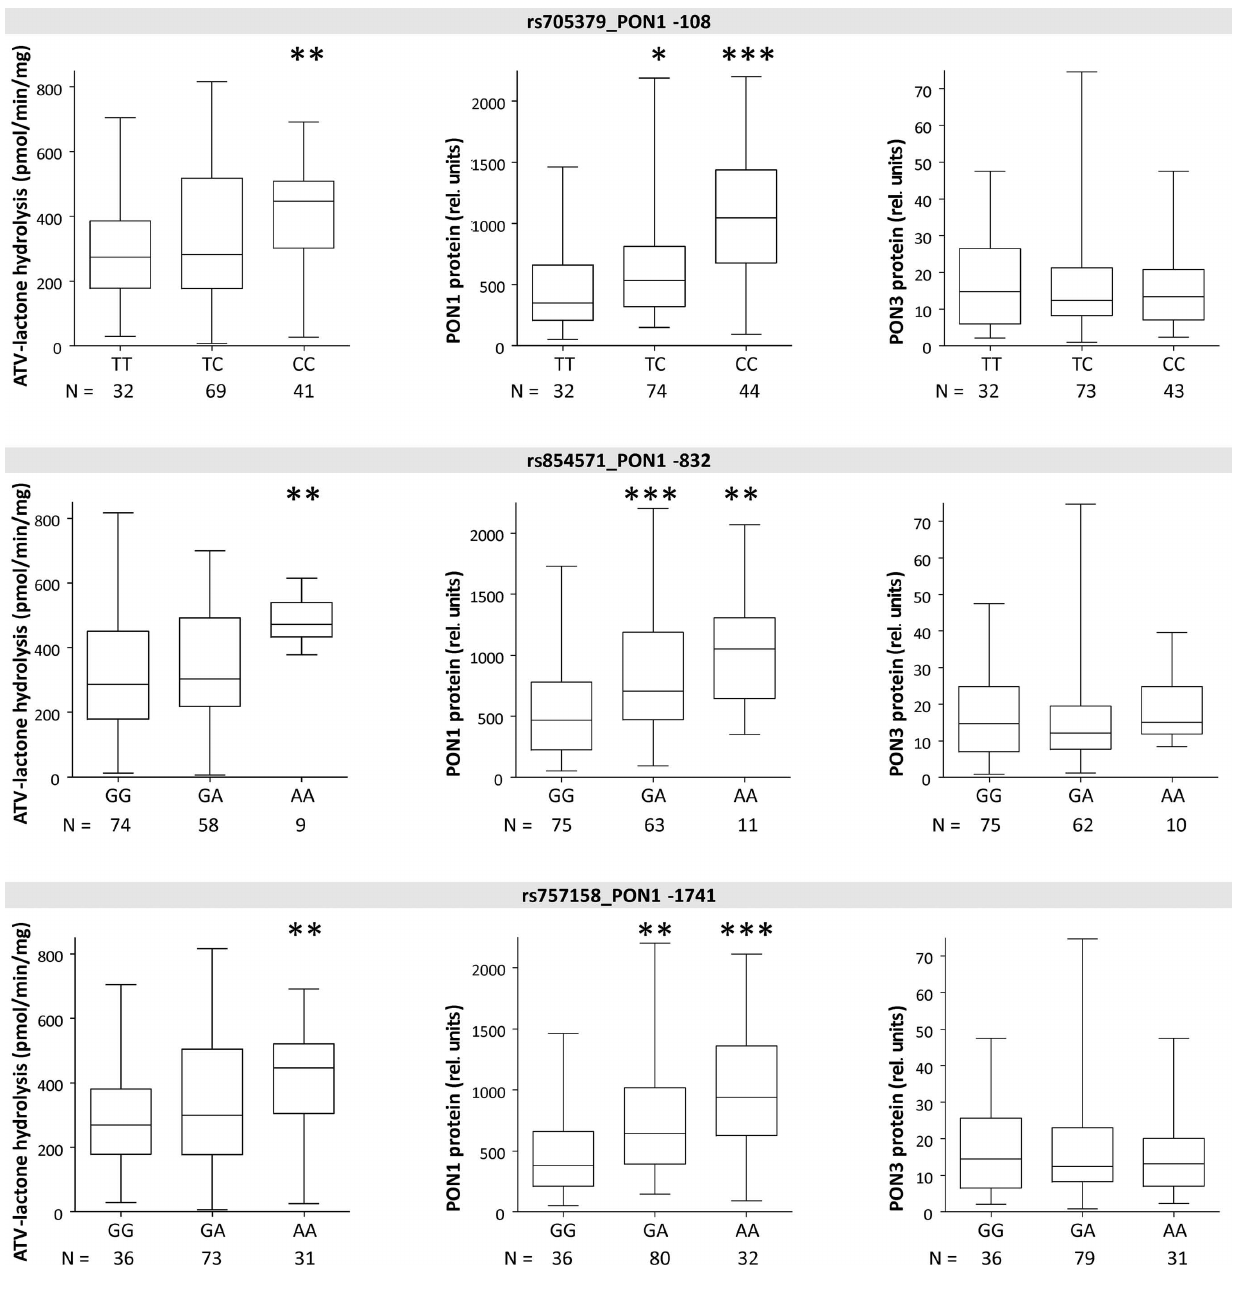
FIGURE 4 | Boxplots of PON1 and PON3 protein expression and microsomal atorvastatin-lactone hydrolysis in liver microsomes for indicated polymorphisms. Heterozygotes and homozygotes of variant allele